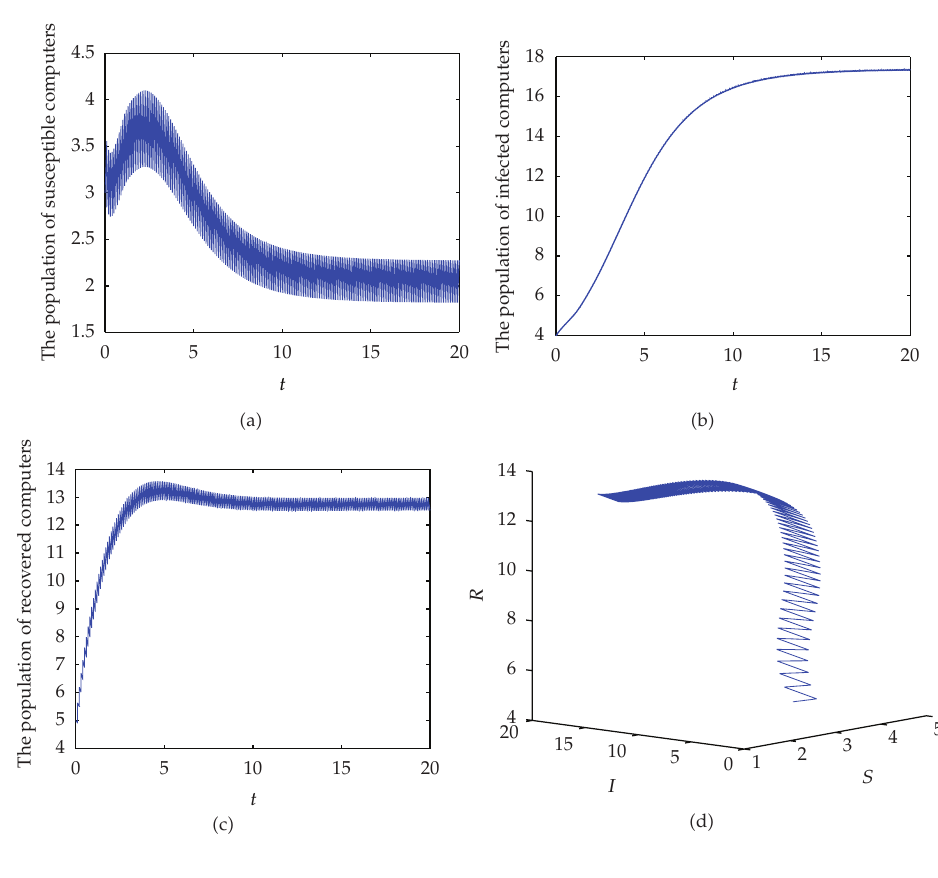
Figure 4: permanence of